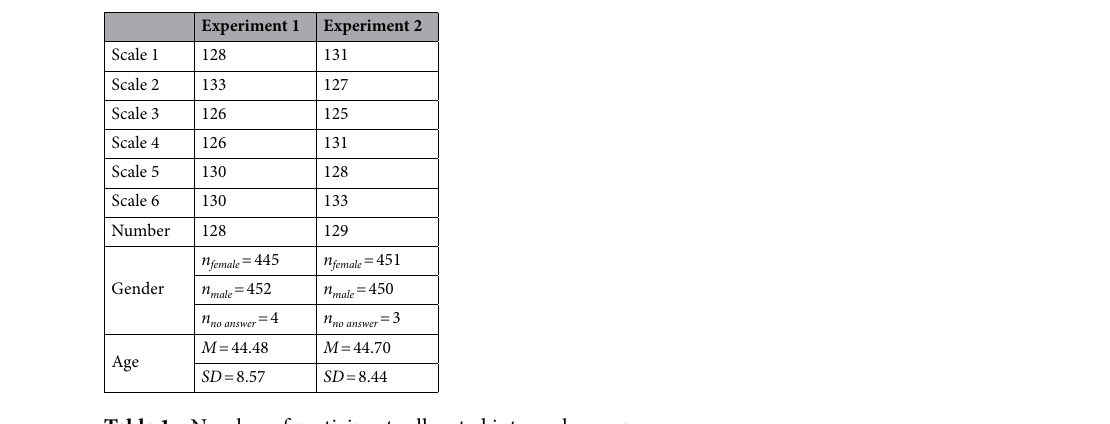
Table 1. Number of participants allocated into each